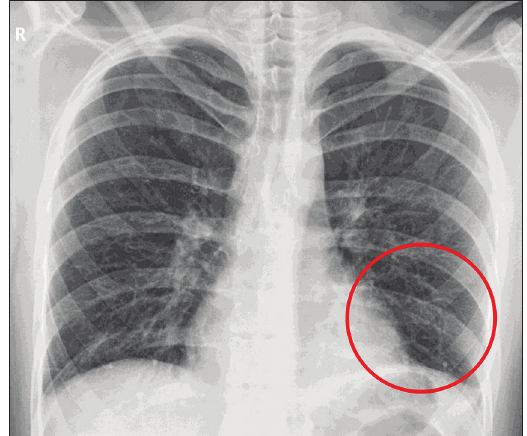
FIGURE 1. Chest X-ray – May 16, 2016.